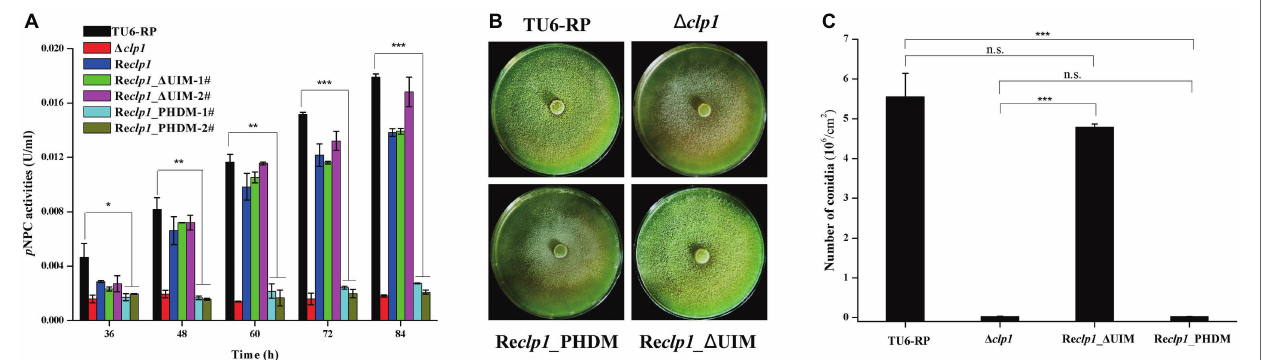
FIGURE 4 | The integrity of the PHD is required for cellulase expression and conidiation. (A) Extracellular p NPC hydrolytic activities of the culture supernatant from the control strain TU6-RP, and the recombinant strains Δ clp1 , Re clp1 , Re clp1 _PHDM, and Re clp1 _ΔUIM cultured on 1% (w/v) Avicel. (B) Conidia formation of the control strain TU6-RP, and the recombinant strains Δ clp1 , Re clp1 , Re clp1 _PHDM, and Re clp1 _ΔUIM on malt extract agar plates at 30°C for 5 days. (C) Counting of conidia produced by the strains in (B) . Significant differences ( t test, * p < 0.05, ** p < 0.01, *** p < 0.001) were observed in (hemi)cellulase production and conidiation. Values represent the mean of three biological replicates. Error bars are the SD from these replicates.